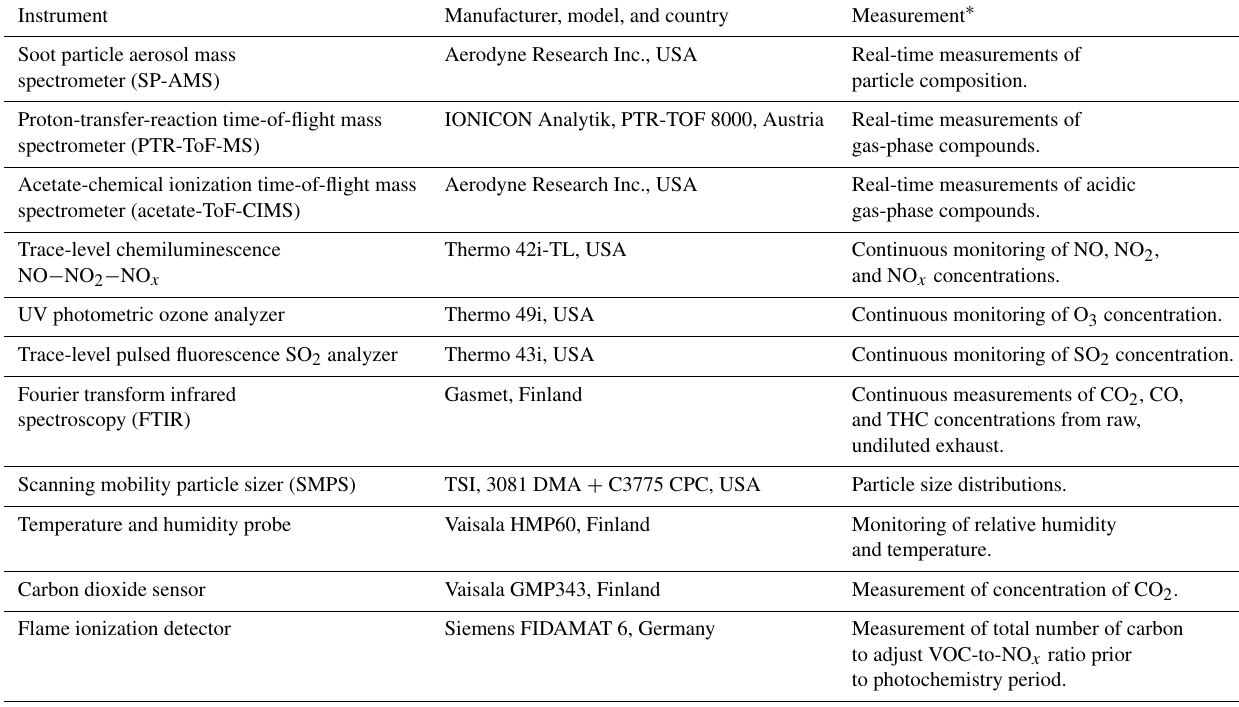
Table 1. Instrumentation used in this study.